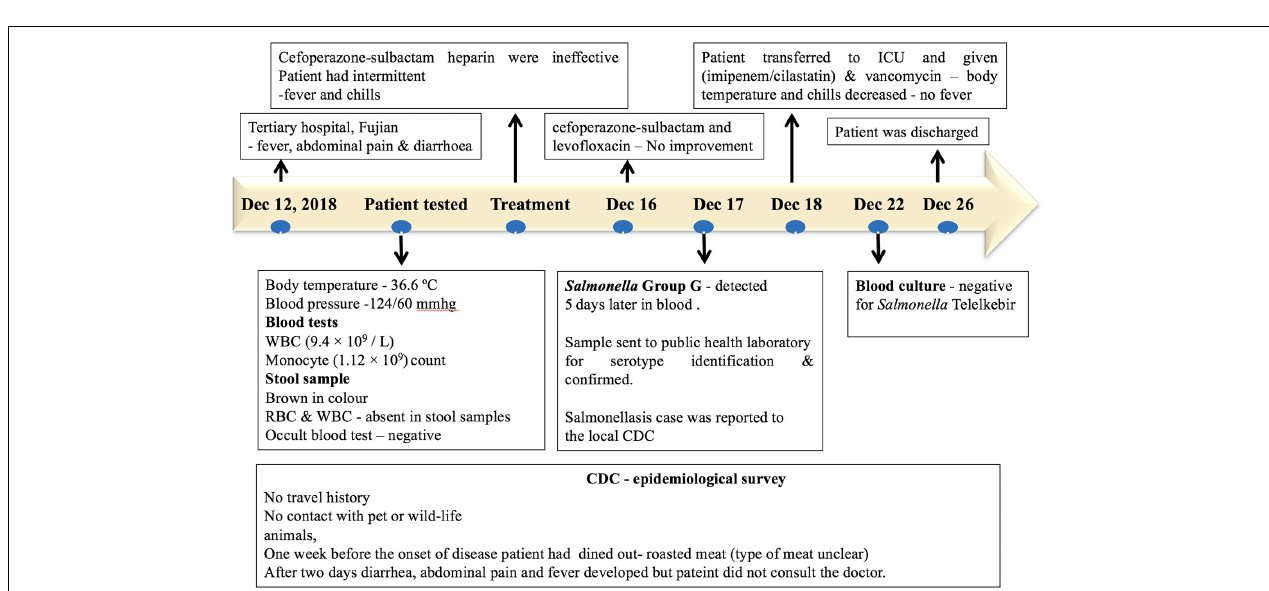
FIGURE 1 | Source location of S . Telelkebir strain genomes used in this study. The red color indicates the presence of this serovar. This map was created using an online service (https://mapchart.net/).